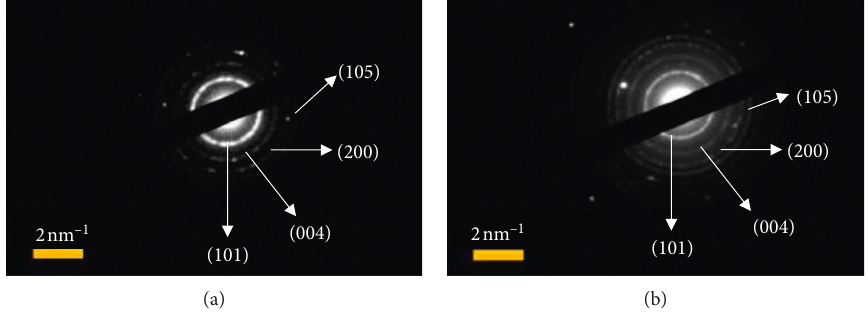
Figure 8: SAED pattern of (a) pure TiO